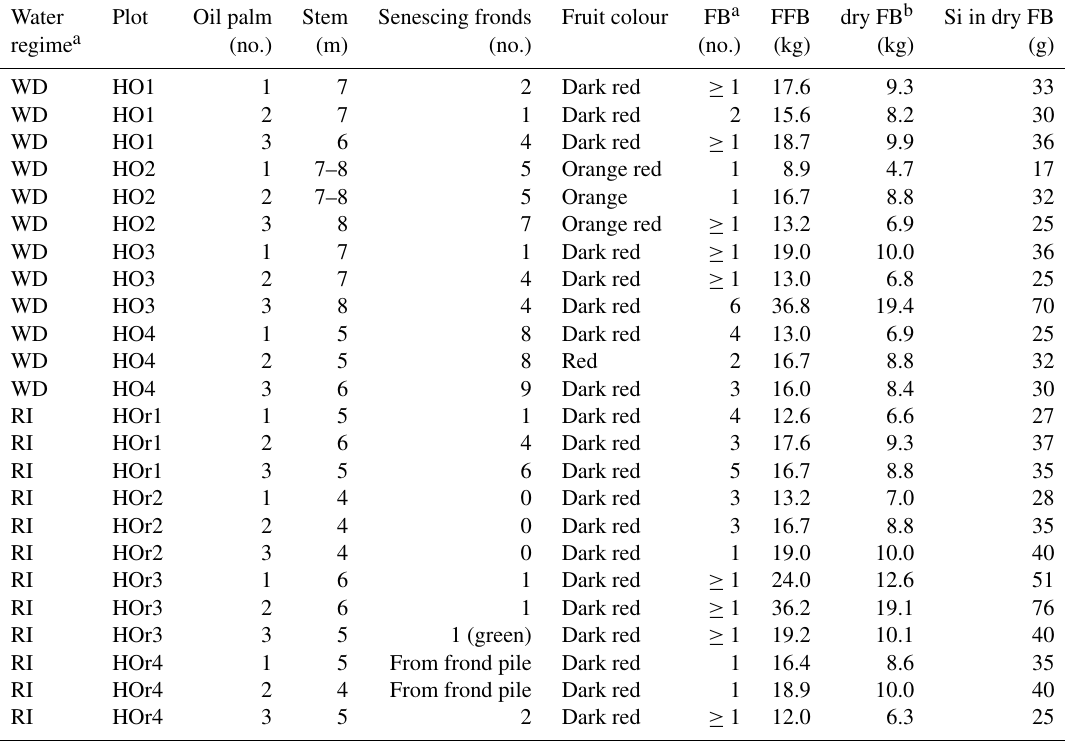
Table B2. Morphological characteristics of oil palms taken for sampling and Si accumulation in fruit bunches. Water Plot Oil palm Stem Senescing fronds Fruit colour FB a FFB dry FB b Si in dry FB regime a (no.) (m) (no.) (no.) (kg) (kg) (g)